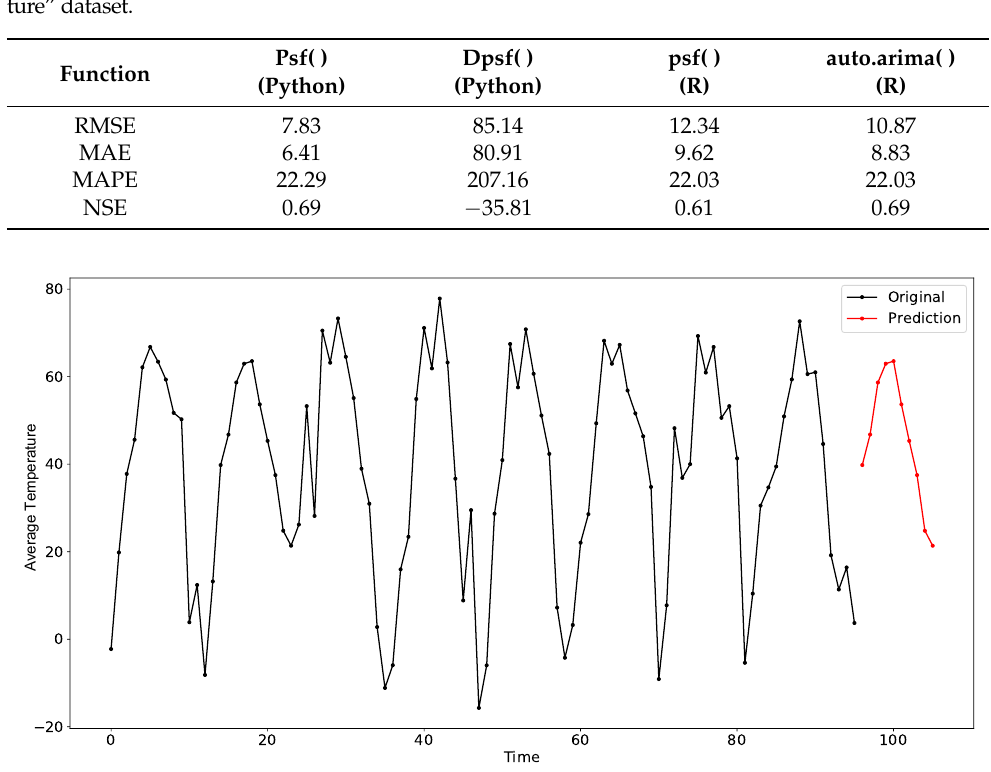
Figure 16. Plot showing result of psf_plot() for the “Average Temperature” dataset.